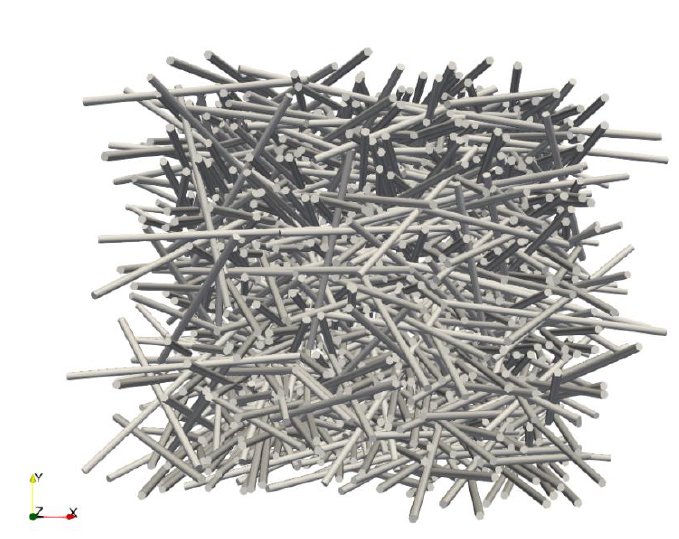
Figure 2. Initial fiber alignment for V15.